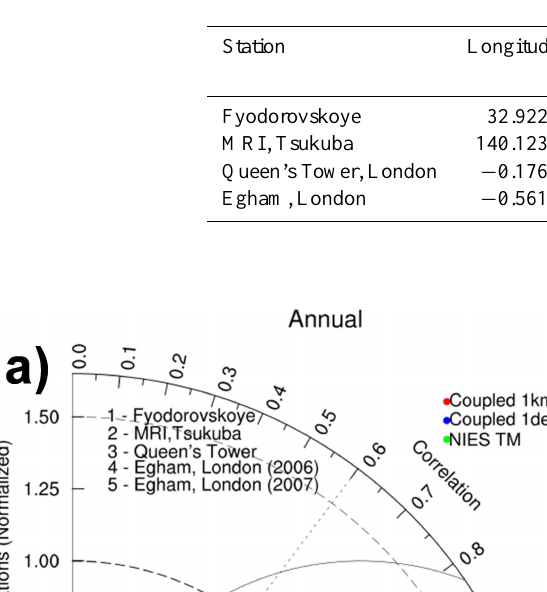
Table 2. General information on the stations.